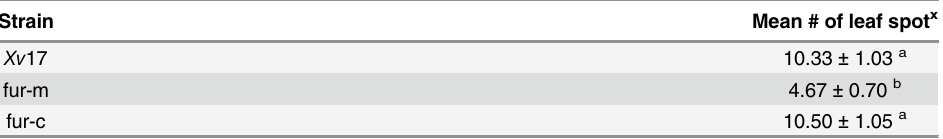
Table 4. Virulence of Xv strains on tomato